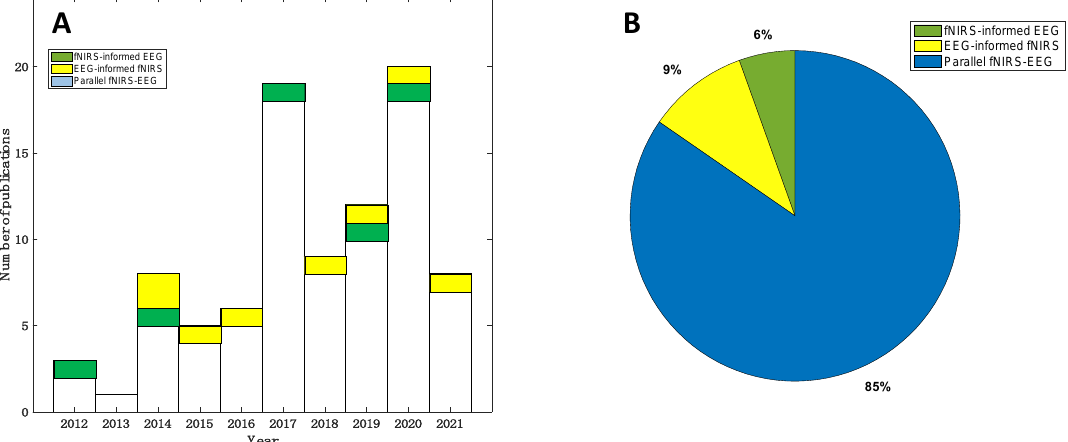
Figure 4. Literature summary of concurrent EEG–fNIRS studies: ( A ) Yearly publications from 2012 to 2021 and ( B ) distribution of each type of concurrent fNIRS-EEG studies.